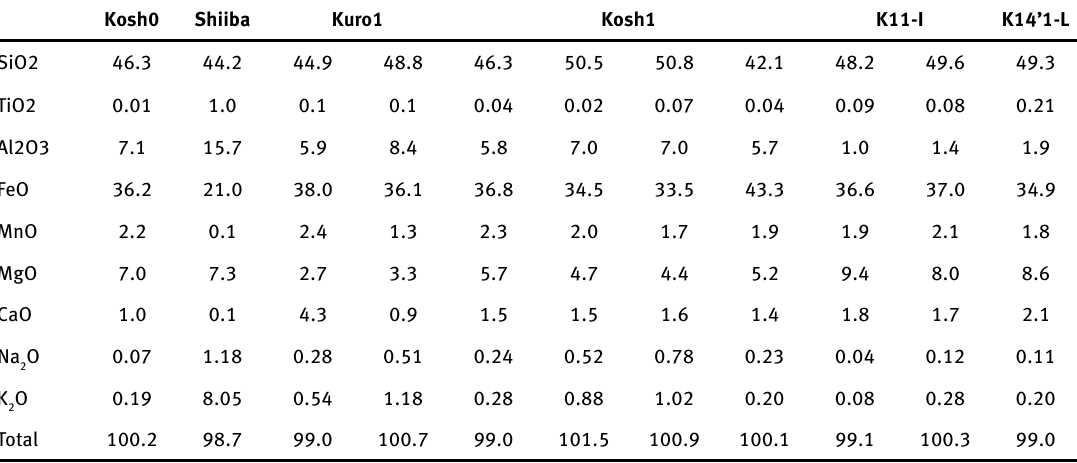
Table 2. Chemical compositions (wt.%) of clinopyroxene microlites in the Kyushu